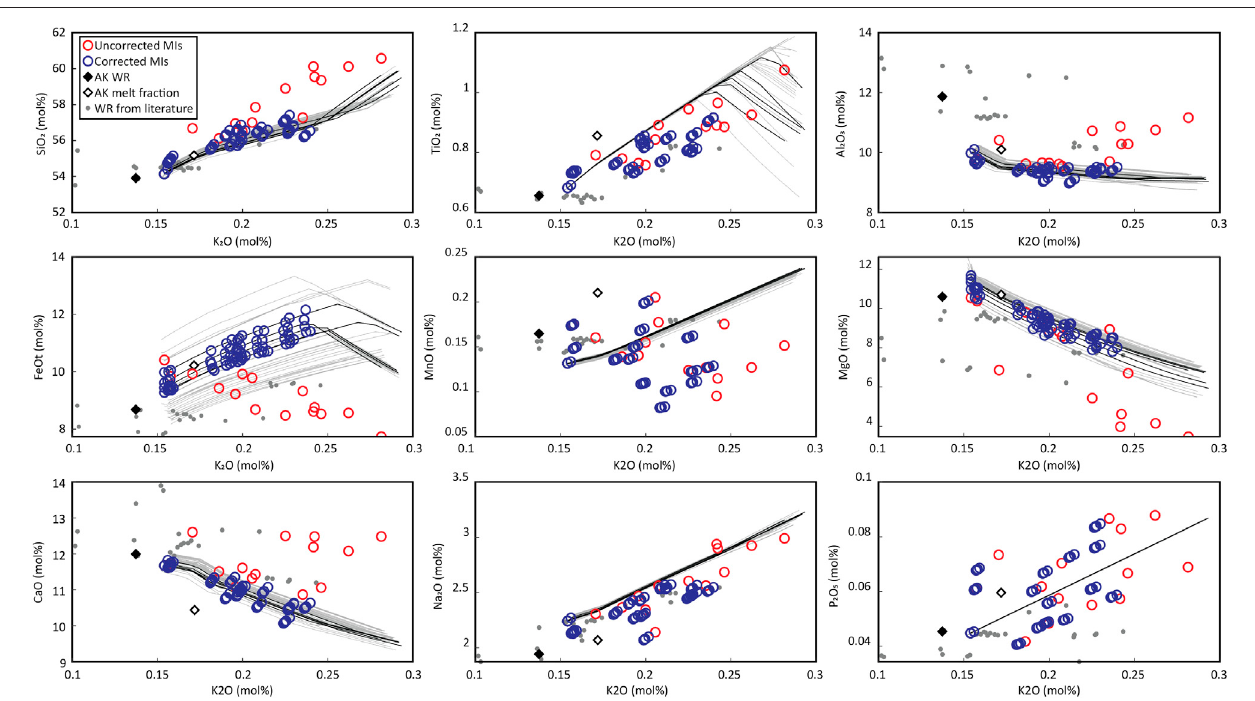
FIGURE9| VariationdiagramsofthecorrectedMIs.RedcirclesaretheuncorrectedMIcompositions.ThegreylinesindicatetheFCmodelsthatarebelowtheGoF 1 σ limitof Figure8 .BlacklinesaretheFCmodels fi lteredbytheirintersectionwiththeestimatedmeltfractioncomposition(whitediamond).Bluecirclesarethecorrected MI compositions for each of the models de fi ned by the black